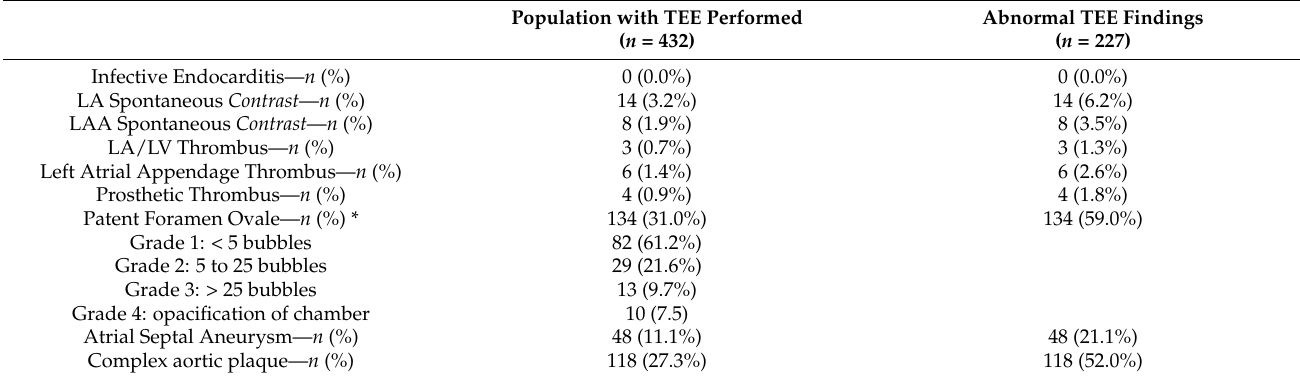
Table 3. Transesophageal Echocardiography Findings Considered as Potential Cardiogenic Source of Embolism. Population with TEE Performed Abnormal TEE Findings ( n = 432)